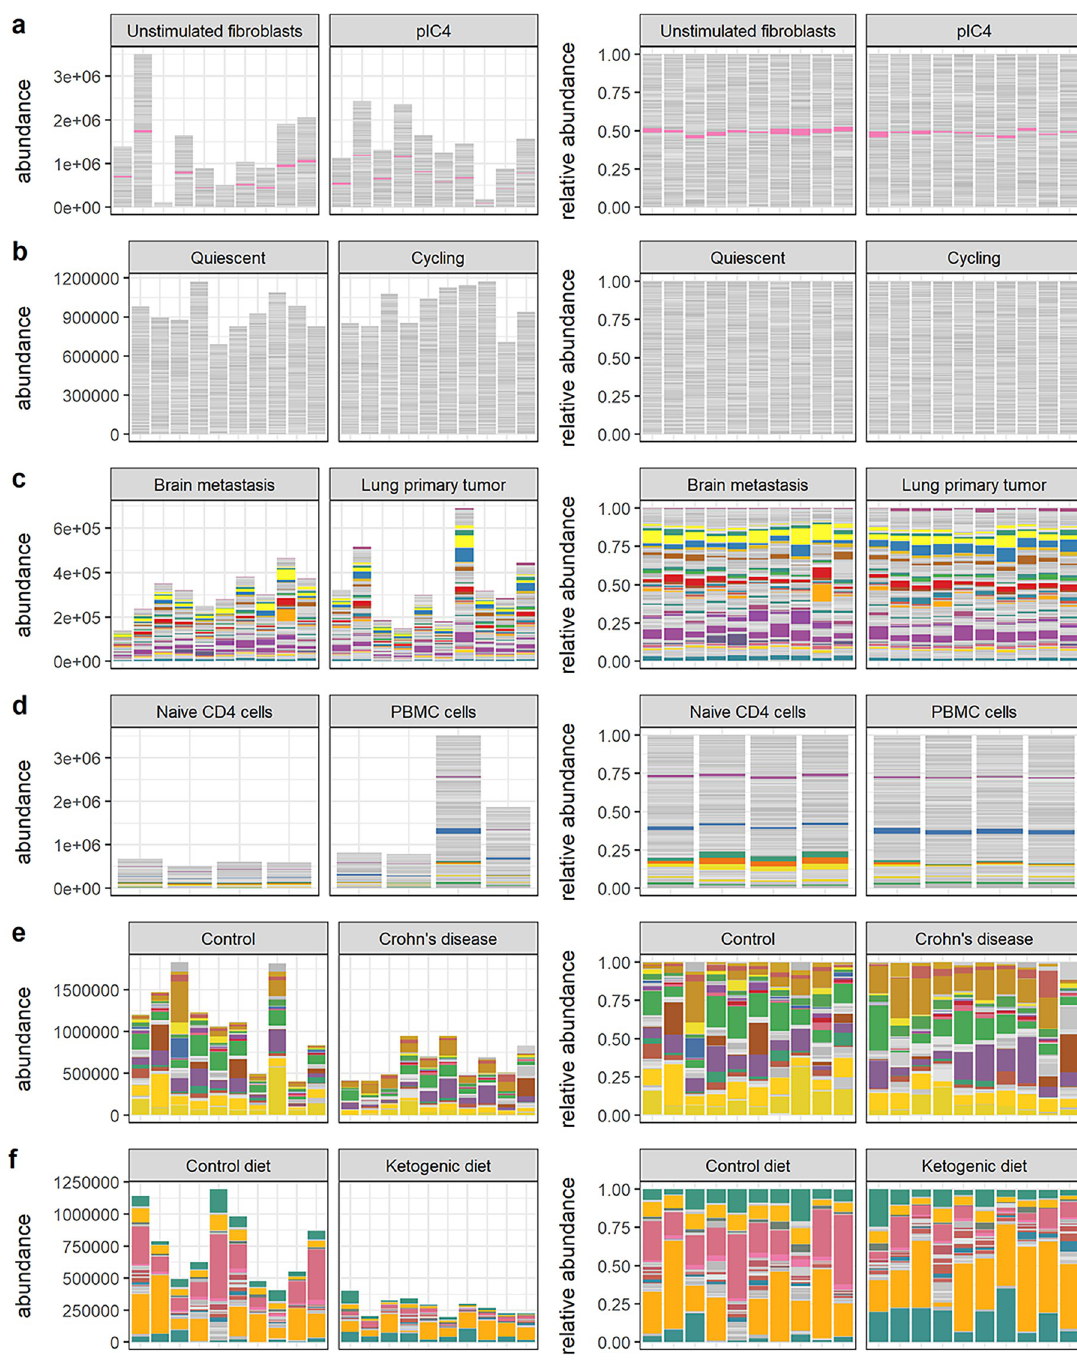
Fig 3. Visual summaries of real data sets 1–6. Visual summaries of nominal abundances (left panels) and relative abundances (right panels) for a) Hagai et al. b) Hashimshony et al. c) Song et al. d) Monaco et al. e) Vieira-Silva et al. f) Barlow et al. Features (genes or bacterial sequence variants) with at least 1% relative abundance across all samples are colored; all other features are